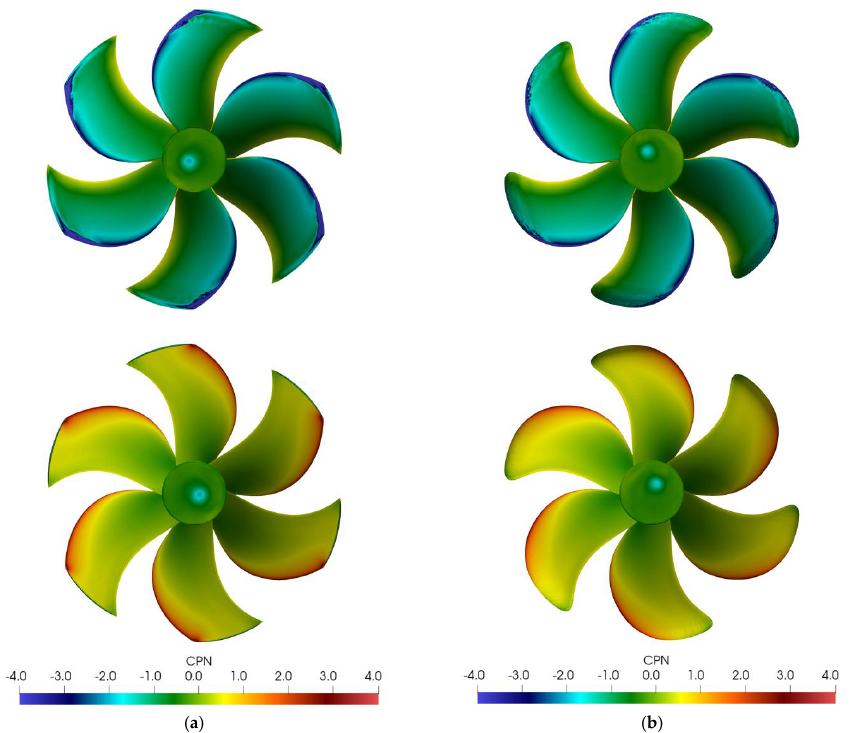
Figure 4. Pressure distributions (C PN ) on the pressure and suction side of the propellers. Advance coefficient J equal to 0.6. Instantaneous snapshot after 22 propeller revolutions. ( a ) Conventional CLT; ( b ) New generation CLT.